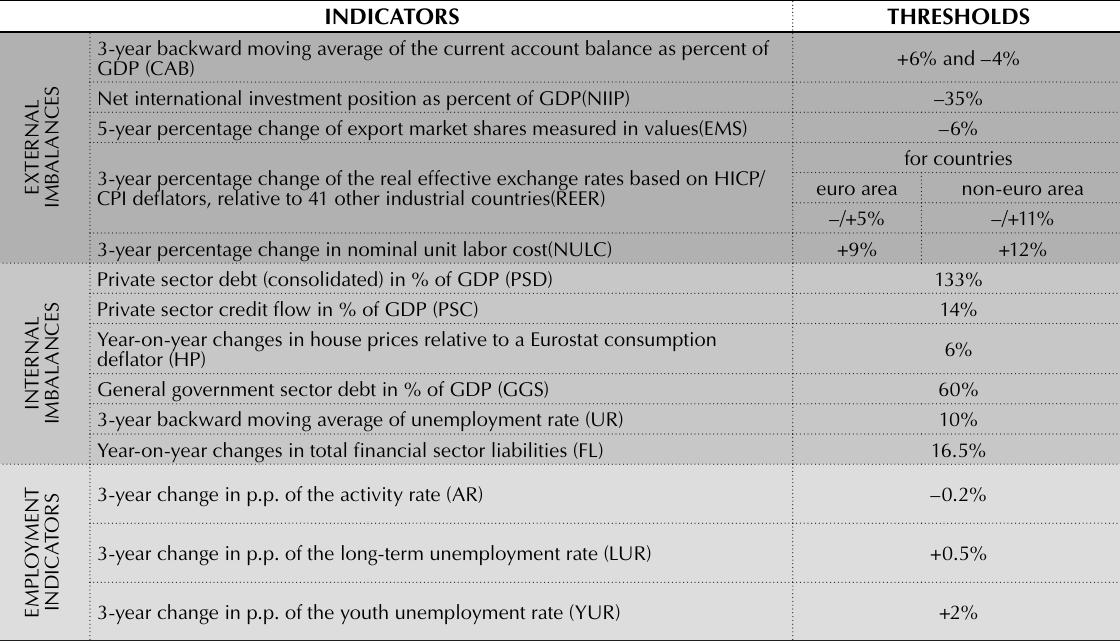
Table 2. The main indicators to measure the macroeconomic